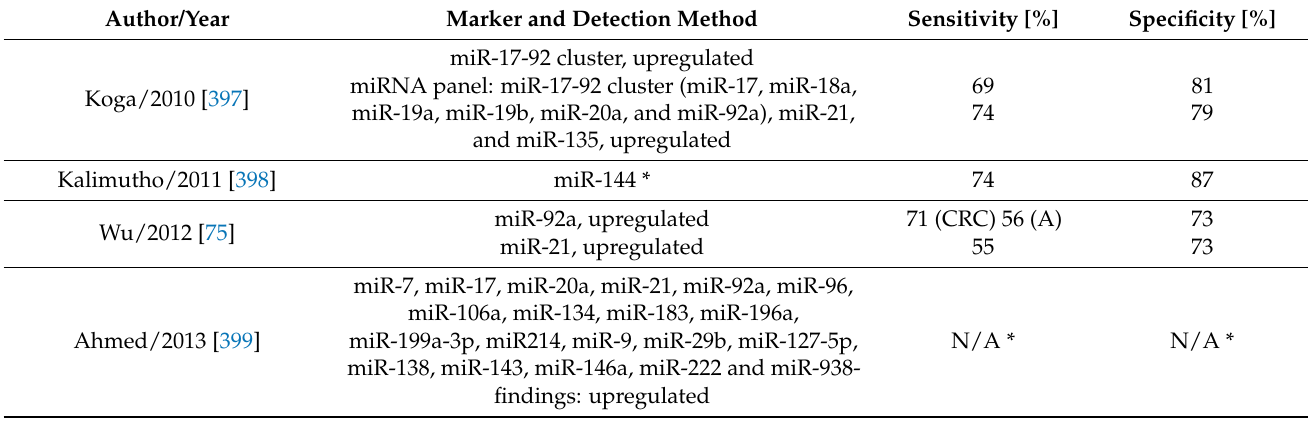
Table 8. According to Loktionov in modification noninvasive stool miRNA biomarker for CRC detection